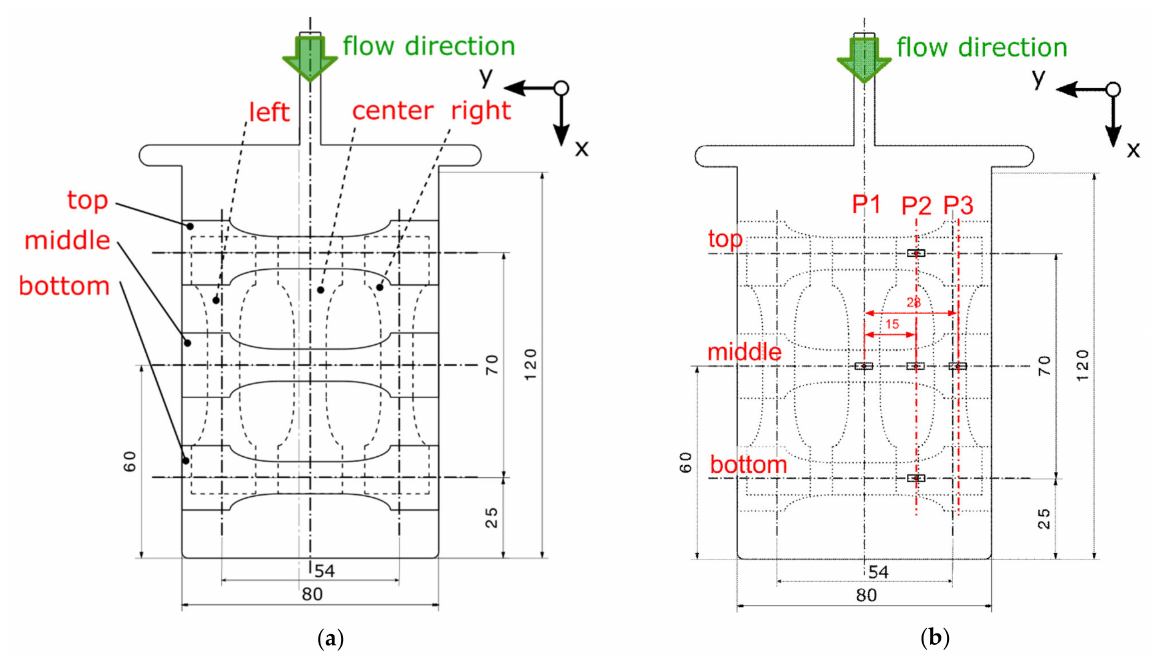
Figure 3. Specimen extraction ( a ) and extraction position of µ CT-samples ( b